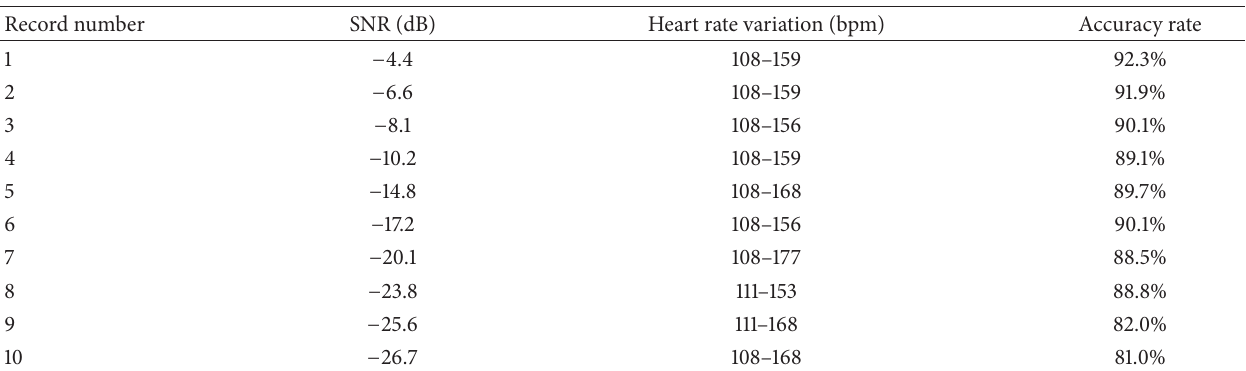
Figure 1: Fetal heart rate detection for an fPCG signal. (a) A low noise fPCG signal; (b) CFS analysis. Cycle frequency indicated by the dominant peak is 2.35 Hz (141bpm). (c) A heavy noise fPCG signal; (d) CFS analysis. Cycle frequency indicated by the dominant peak is 2.51 Hz (151bpm). Table 1: Summary of the